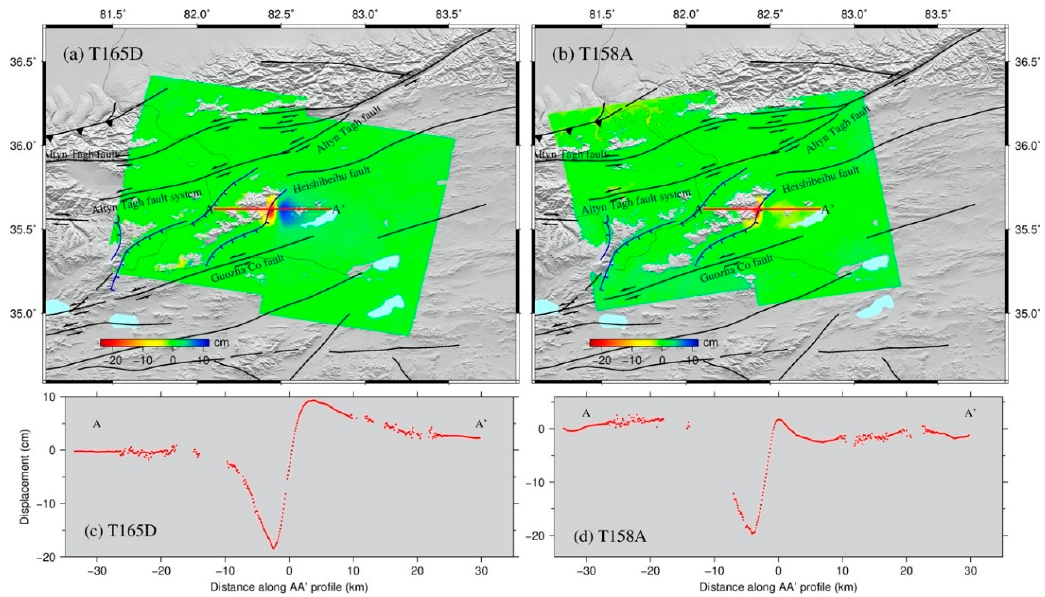
Figure 3. Interferograms and their atmospheric errors from Generic Atmospheric Correction Online Service (GACOS) model. ( a,b ) Original interferograms for T165D, T158A. ( c,d ) Atmospheric phase errors for relative interferograms.